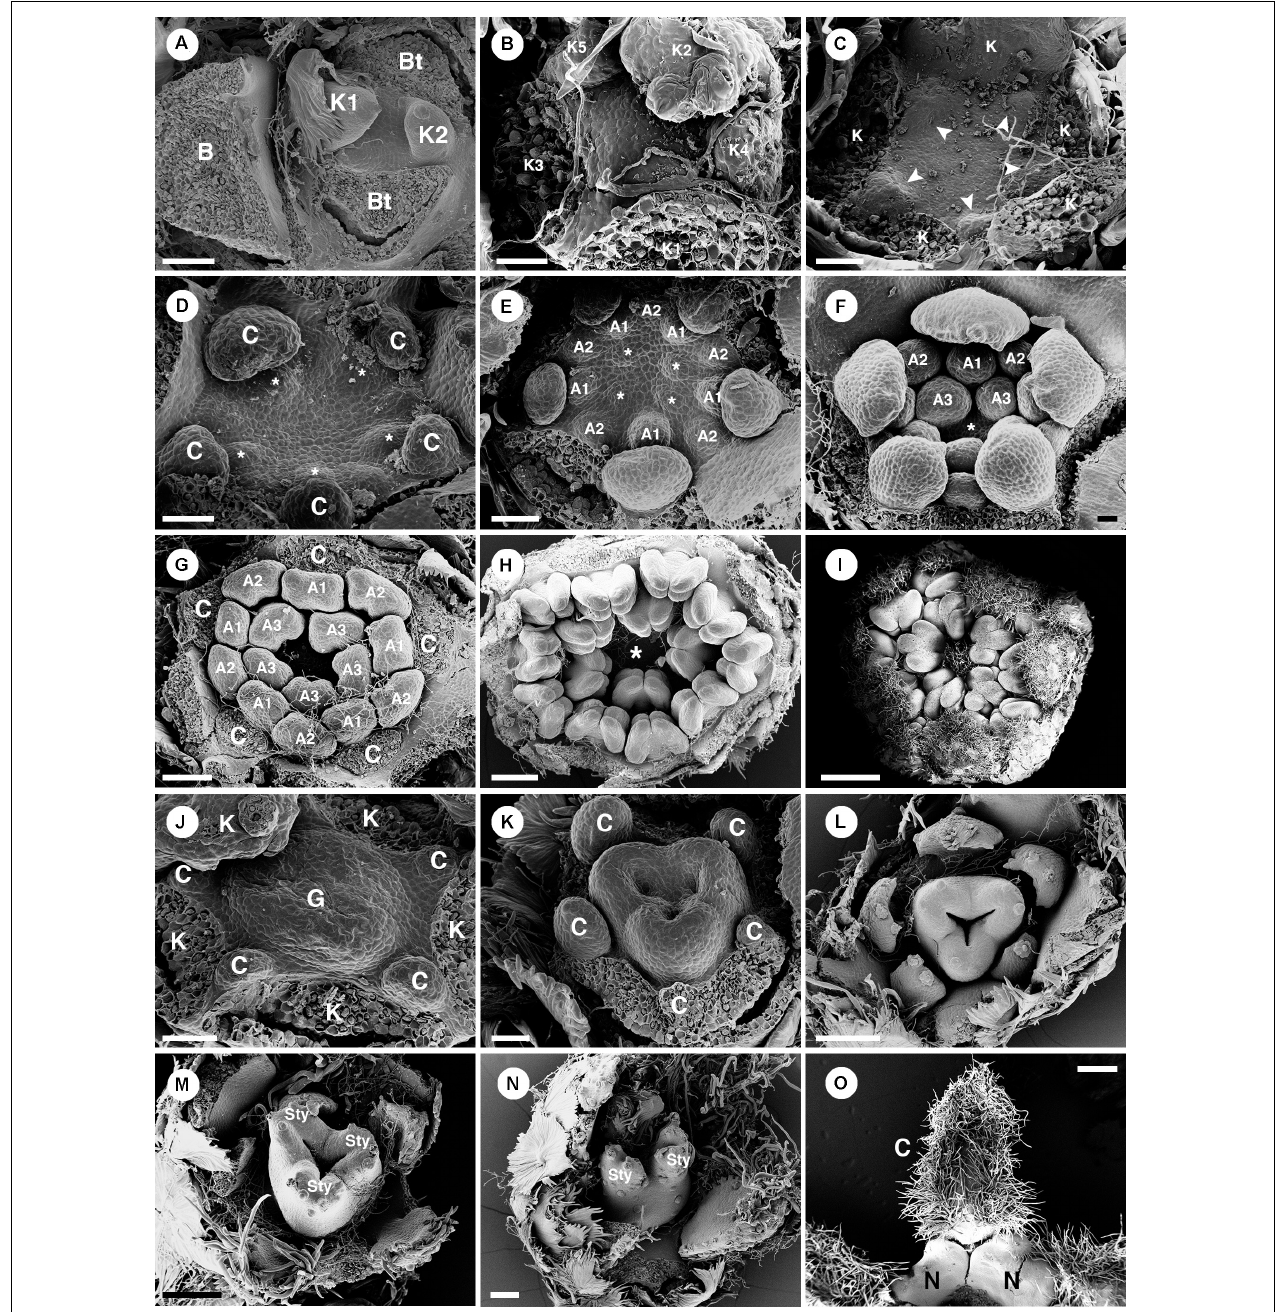
FIGURE 9 | Ontogeny of staminate (A–I) and pistillate (J–O) flowers of Croton alabamensis . (A) A young convex floral primordium subtended by a bract and two bracteoles. The first and second sepals are visible. (B) Soon, more sepal primordia initiate and grow unequally in a quincuncial (2/5) pattern. Note, the floral primordium is still convex in shape. (C) After that, a hypanthium starts to form while five petal primordia initiate alternating with sepals (arrowhead). (D) Later, petals continue to grow and clearly show unequal growth. Two whorls of stamens are visible. Stamens from the antepetalous whorl (asterisk) is bigger than stamens from the alternipetalous whorl. Note, a hypanthium is well developed making the flower to become cup-shaped. (E) Next, the third whorl of stamens develops centripetally (asterisk). (F) The hypanthium starts to grow while petals and three whorls of stamens are visible. There is an empty space in the middle of the flower (asterisk). (G) Flower in later stage with all perianth parts removed shows three whorls of stamens. The outermost whorl alternates with petals. (H) Apical view of older flower bud shows central empty space (asterisk). (I) Later, stamens grow and bend toward the center but never become inflexed. (J) Pistillate flower in an early stage shows five petal primordia and a tricarpellate ovary formation. (K) In a later stage, petal primordia continue to grow unequally. Three fused carpels are clearly seen. (L) Next, petals continue to expand and the ovary start to close. (M) A style starts to form on top of each carpel. (N) Three bilobed styles are visible on the ovary. (O) At a much older stage, five bilobed nectary glands are formed alternating with petals. K, sepal; C, petal; A, stamen; G, ovary; Sty, style; N, nectary. Scale bars: (A,G,N) = 100 µ m; (B,F) = 30 µ m; (C–E,J,K) = 50 µ m; (H) = 200 µ m; (I) = 1,000 µ m; (L,M) = 150 µ m; (O) = 400 µ m.